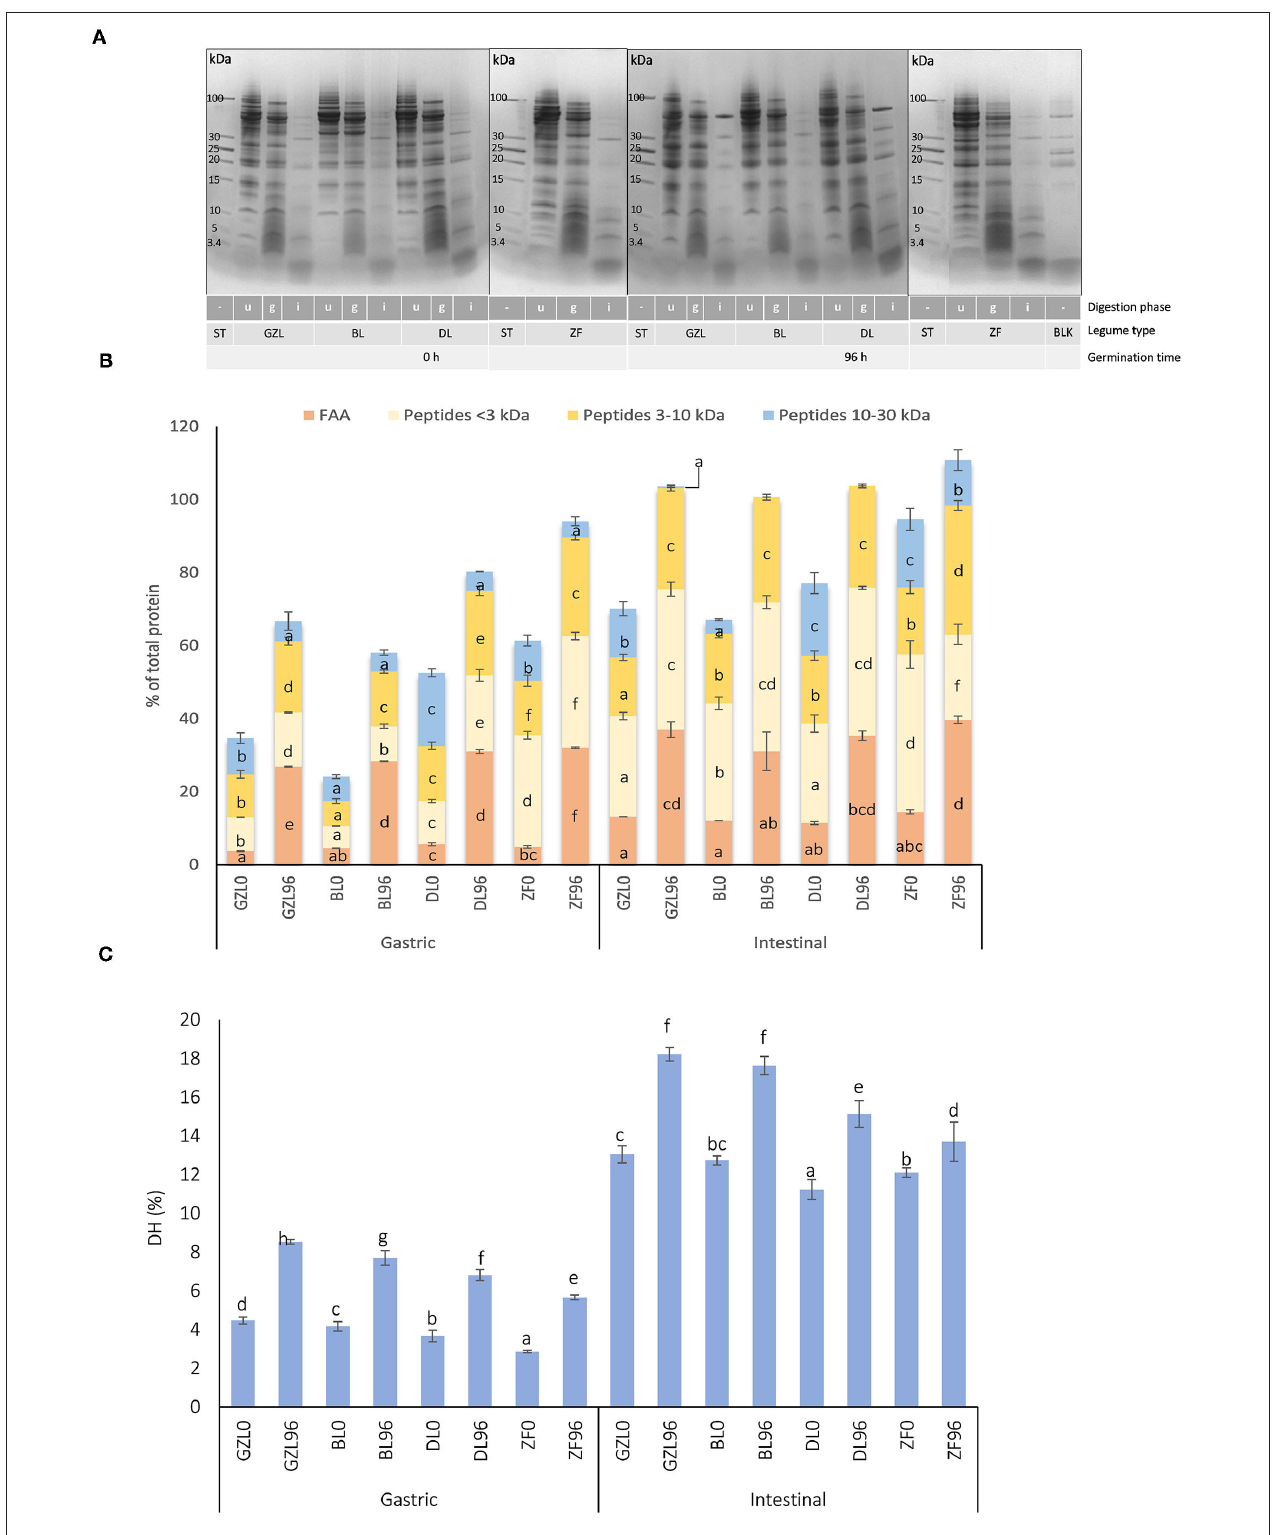
FIGURE 3 | (A) SDS-PAGE protein profiles of dry and sprouted lentil and fava bean seeds (20 ◦ C, 96h) at different times of in vitro gastrointestinal digestion. (B) The distribution of nitrogen fraction after the simulated gastric and intestinal digestion of lentil and fava bean seed types before (GZL0, BL0, DL0, and ZF0) and after